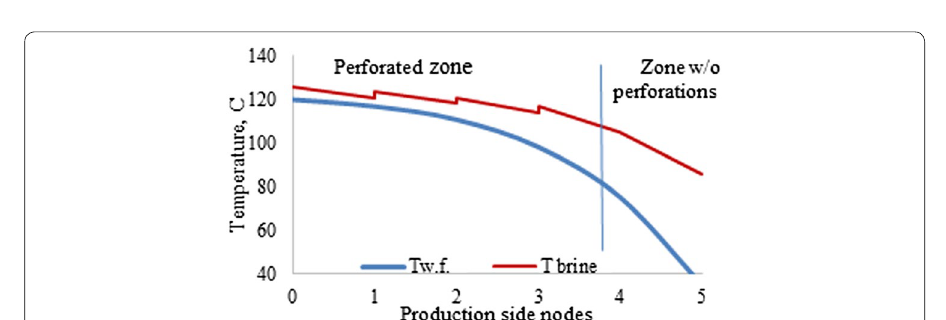
Fig. 15 Equal influx temperature development. The well has only 4/5 length